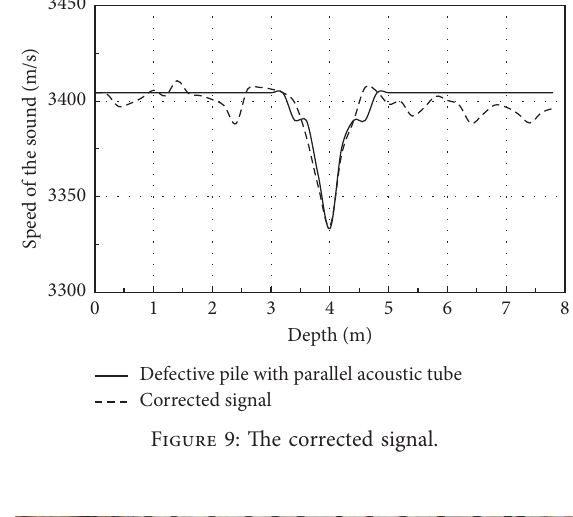
Figure 9: The corrected signal.